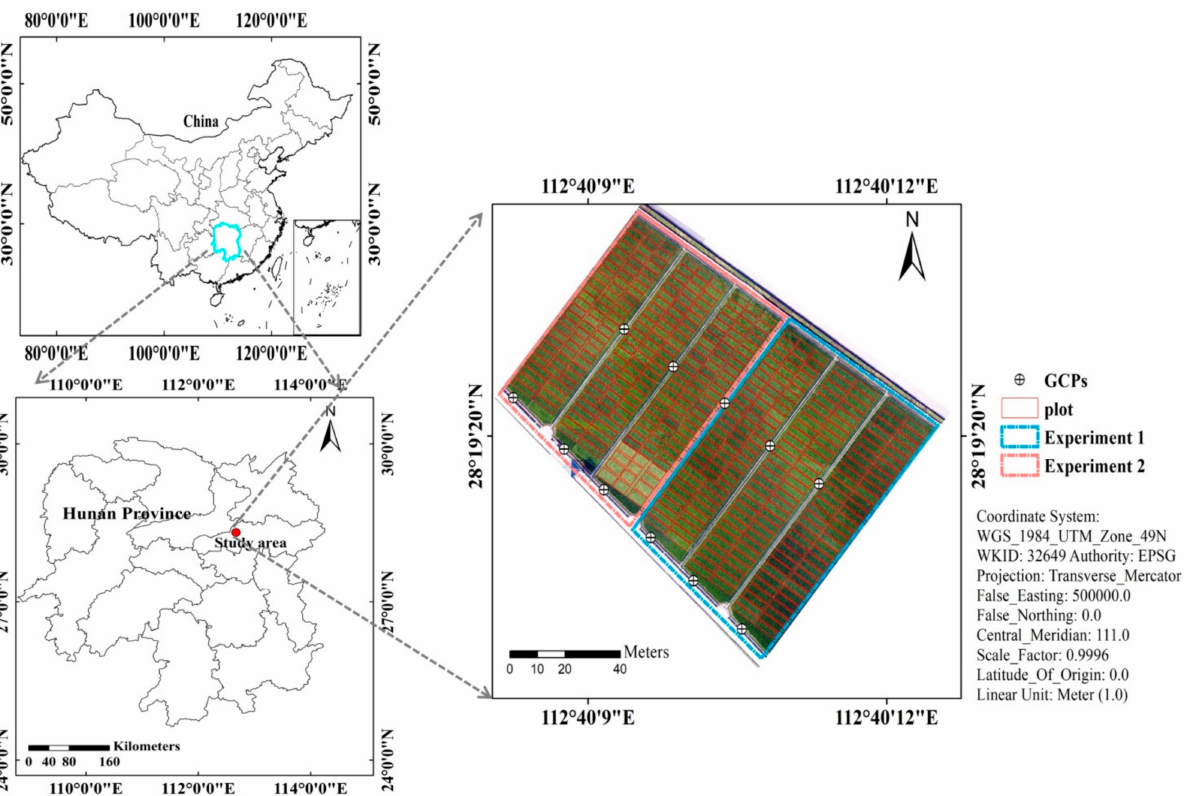
Figure 1. The location of the study area in Changsha City, Hunan Province, China (Experiment 1: late-maturity cultivars, Experiment 2: early-medium-maturity cultivars).